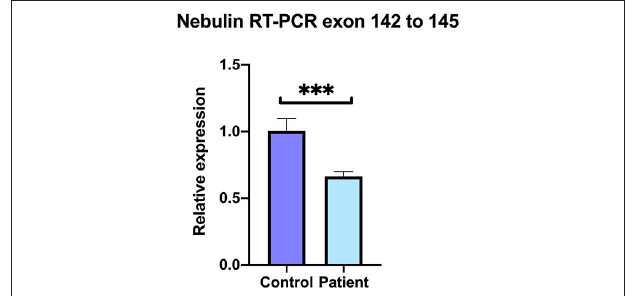
FIGURE 6 | Decreased levels of nebulin expression in the patient’s skeletal muscle. Quantitative real-time RT-PCR comparative analysis on the covering region from exons 142–145. Relative expression represented as fold ratio of nebulin fragments in the patient biopsy compared with control. Fold changes were normalized using the three reference genes beta-2-microglobulin (B2M), hypoxanthine phosphoribosyltransferase 1 (HPRT1), and glyceraldehyde-3-phosphate dehydrogenase (GAPDH). Data are represented as mean of the quadruplicate ± SD. *** P = 0.0005.